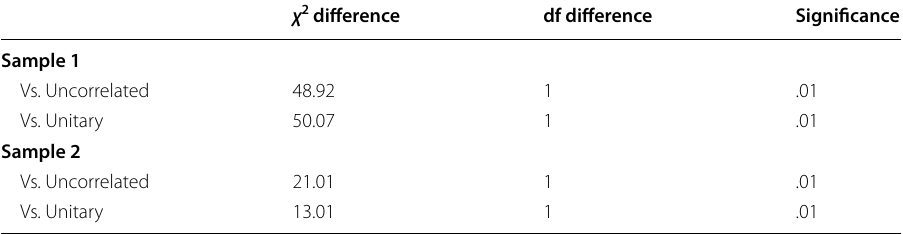
Table 4 Chi-square difference test results (correlated model Vs. unitary and uncorrelated